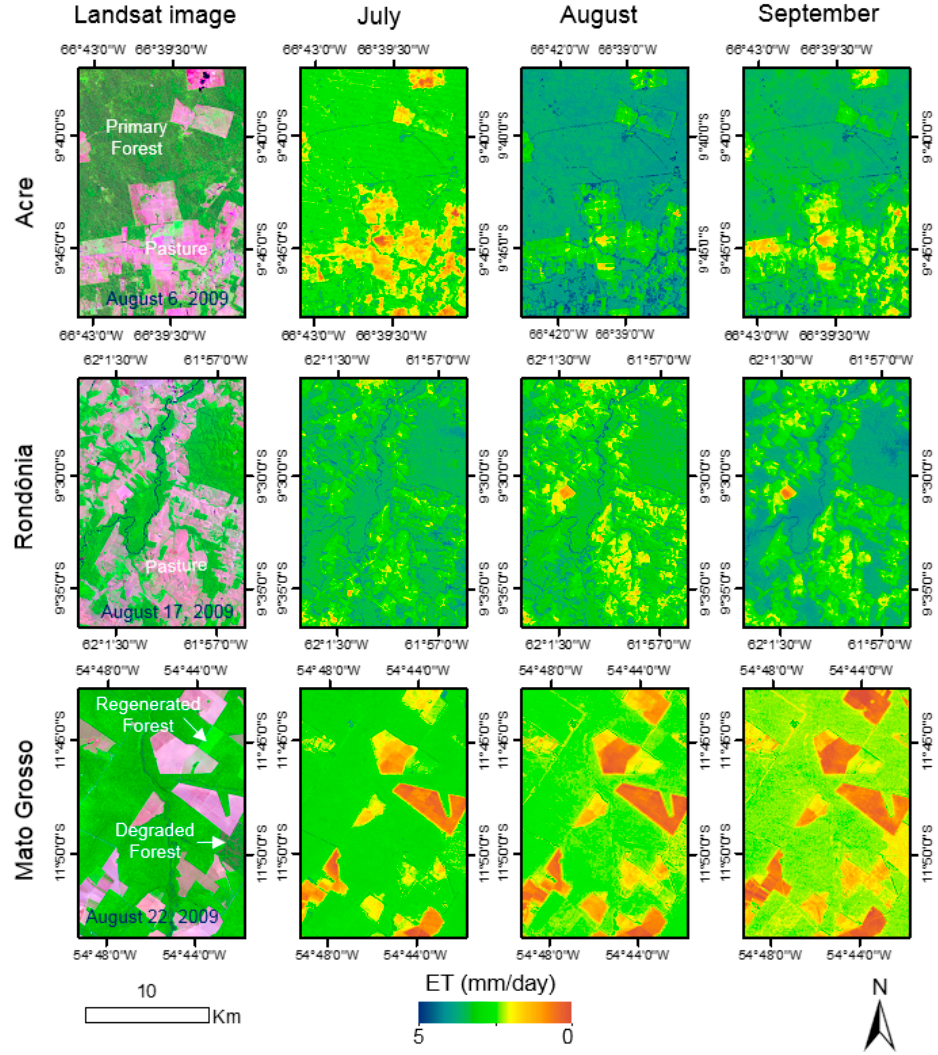
Figure 7. Monthly ET variations from different land cover types during July, August, and September across the study sites in 2009.